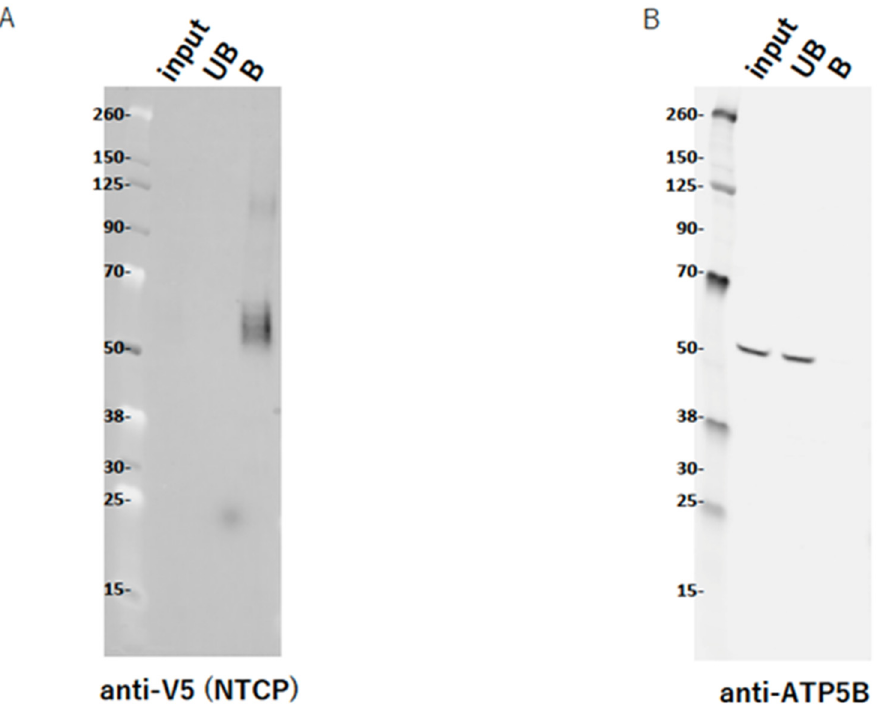
Figure 4. NTCP and ATP5B interaction assay. An NTCP V5-His expression vector was transfected to 293T cells. Total cell lysate was prepared 2 days after transfection, and the expressed NTCP V5-His was purified with Ni-NTA. The input, unbound (UB), and bound (B) fractions were electrophoresed on the SDS-PAGE and analyzed with Western blotting analysis for NTCP ( A , anti-V5) and ATP5B ( B ).